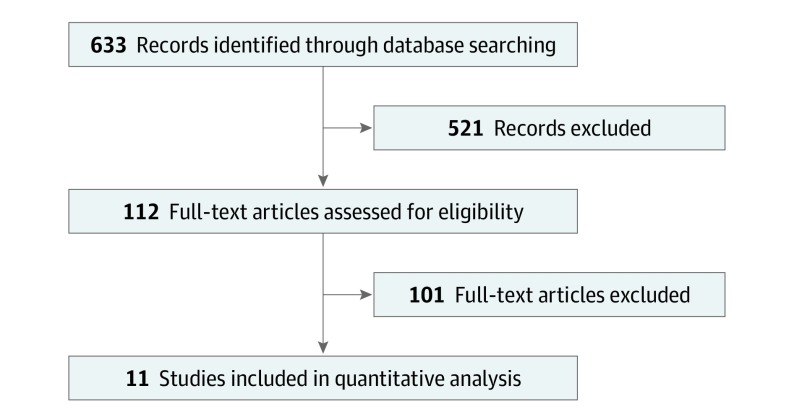
PRISMA Flowchart